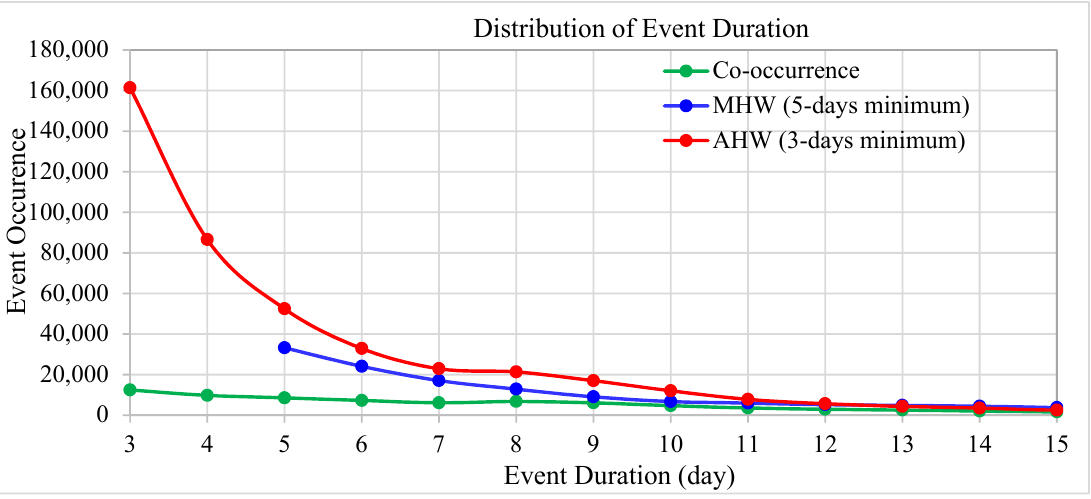
Figure 8. Frequency distribution of event durations of AHWs, MHWs and their co-occurrence for all grid cells within EMED from 1982 to 2021.